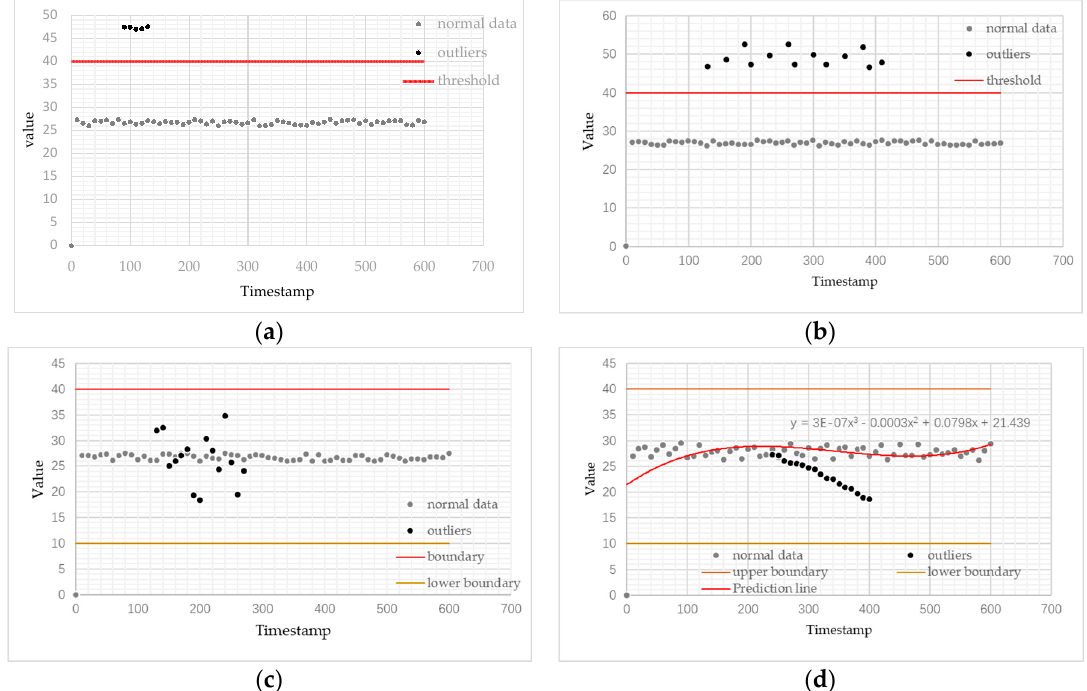
Figure 5. Example cases for system testing. ( a ) Outliers exceed a constant threshold in a short period ( b ) Outliers exceed a constant threshold in a long period ( c ) Outliers act as jitter within boundary threshold ( d ) Outliers deviate prediction line.